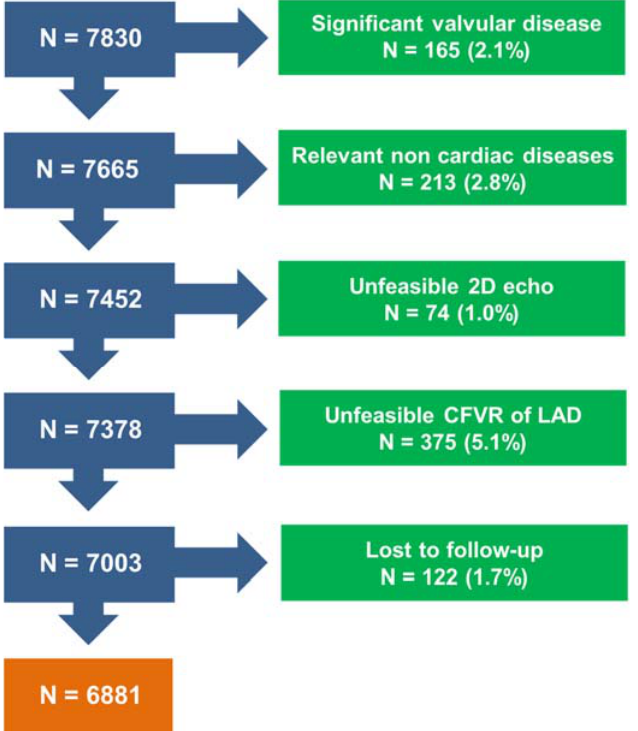
Figure 1. Consort diagram. Flow diagram showing how many individuals were excluded at each exclusion step.